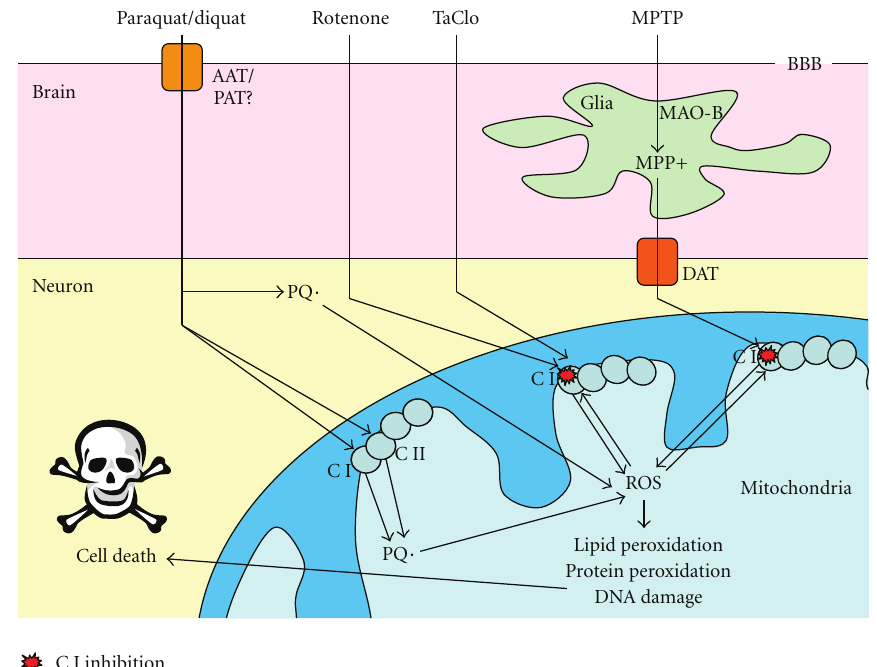
Figure 4: Mechanisms of mitochondrial dysfunction-mediated cell death generated by neurotoxins: Paraquat crosses the blood brain barrier (BBB) by an as yet unclear mechanism, possibly via an amino acid transporter (AAT)/polyamine transporter (PAT), where it enters the cell and is spontaneously reduced to the paraquat radical PQ · or reduced by Complex I or II (CI or II) and can then form reactive oxygen species (ROS). Rotenone and TaClo enter neurons and can cause CI inhibition which leads to the production of ROS. MPTP enters the brain, where it is converted to MPP+ in glial cells by monoamine oxidase-B (MAO-B) which is transported into neurons by the dopamine transporter (DAT). Once in the cell, MPP+ also causes CI inhibition and generation of ROS. ROS formed by these environmental toxins can then exacerbate the CI inhibition as well as causing lipid and protein peroxidation, DNA damage, and, ultimately, cell death.